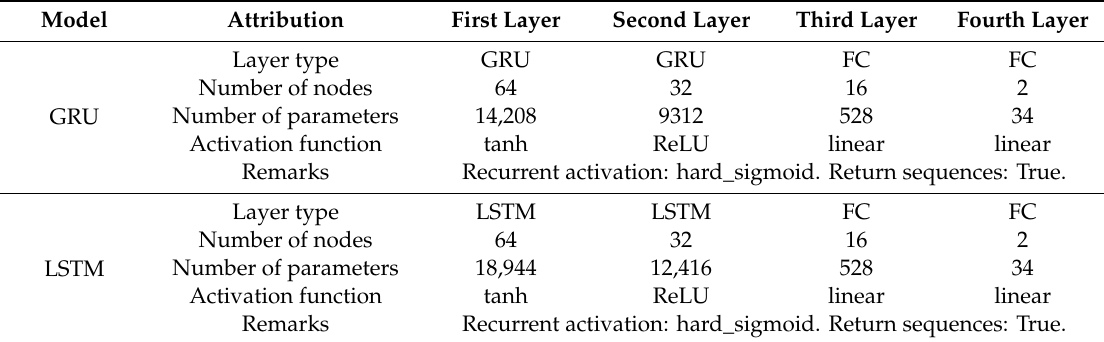
Table 6. Layer attributions of the predictive